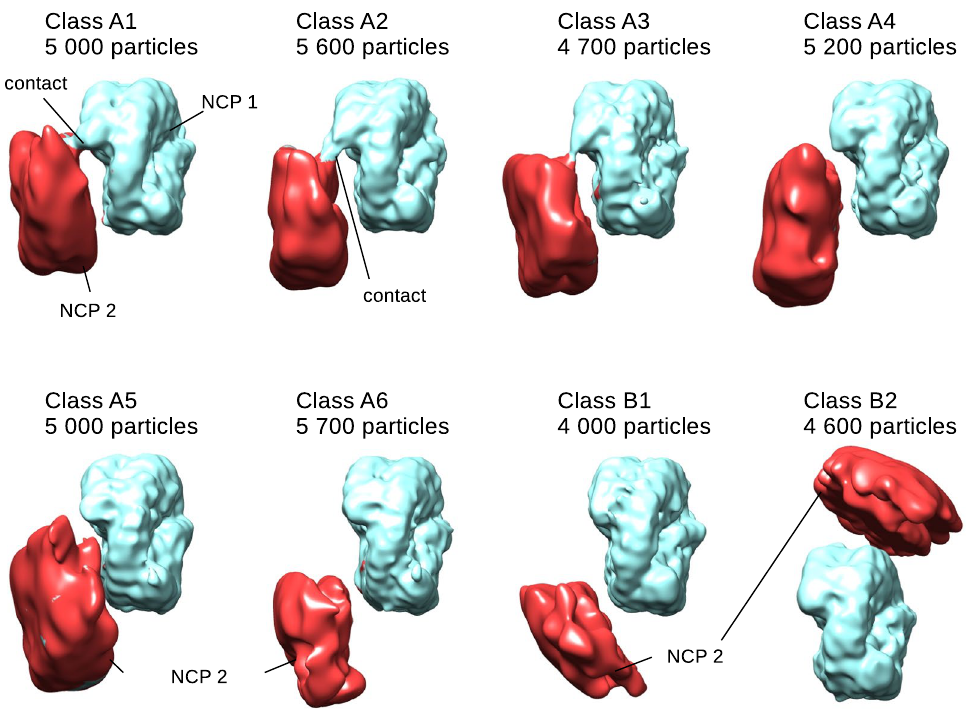
Figure 2. NCP pairs can adopt multiple conformations. Cryo-EM maps of the classes of NCP pairs showing their diverse relative orientations. NCP 1, for which the orientation is fixed between classes, is shown in light blue, and NCP 2 is shown in red. The number of particles for each class is indicated. Note that the strongest contact observed in classes A1–A3 is formed proximal to the entry/exit site of NCP 1 and the DNA of NCP